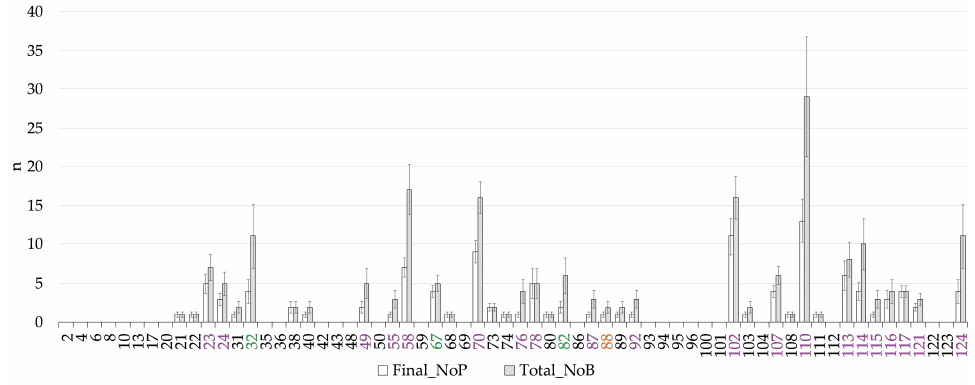
Figure 3. Final_NoP (final number of pods) and Total_NoB (total number of beans) for each genotype at the end of the 2020 heat stress trial. Genotypes with a higher Total_NoB than the reference variety Bonela (orange, 88) in 2020 are colored in purple, while genotypes 32, 67 and 82 that developed more beans than Bonela in 2018 and 2020 are marked in green (cf. Figure